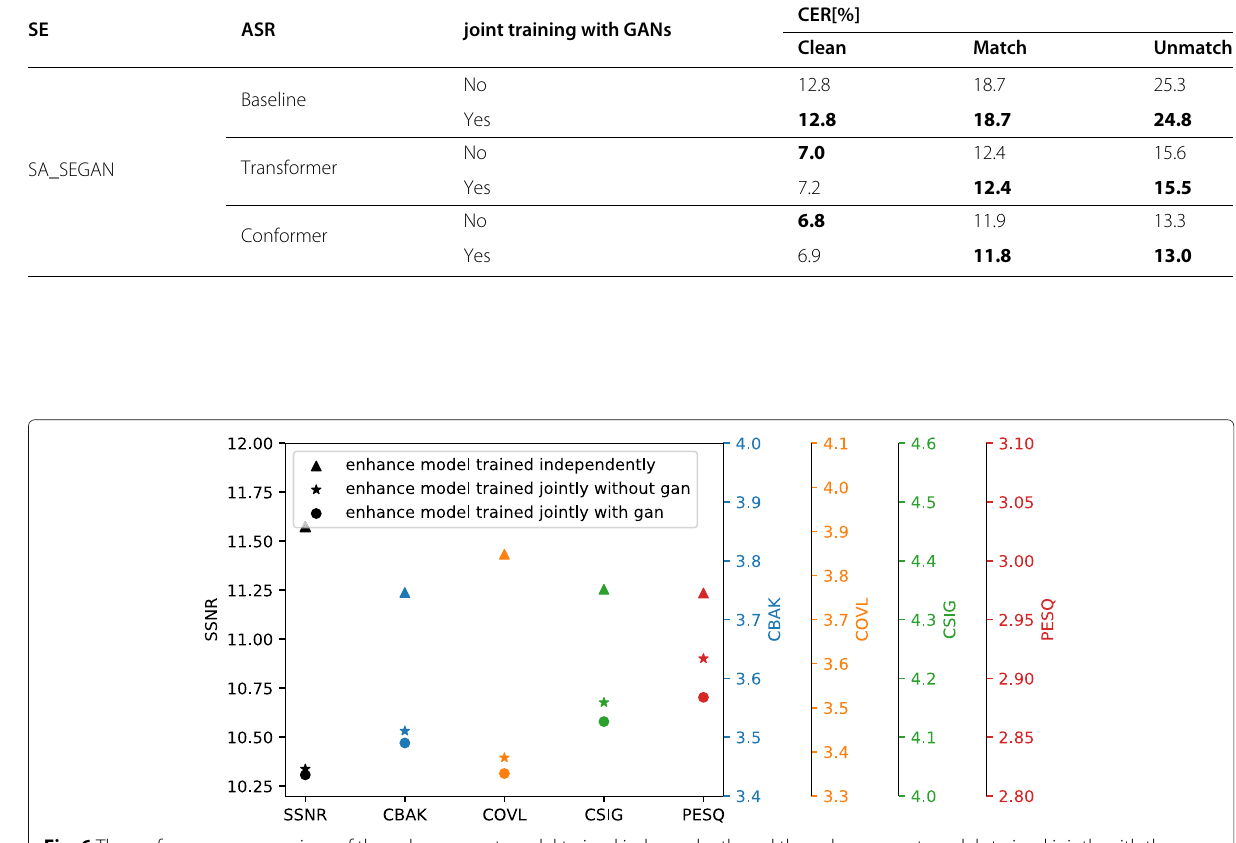
Fig. 6 The performance comparison of the enhancement model trained independently and the enhancement models trained jointly with the baseline ASR model without and with GAN